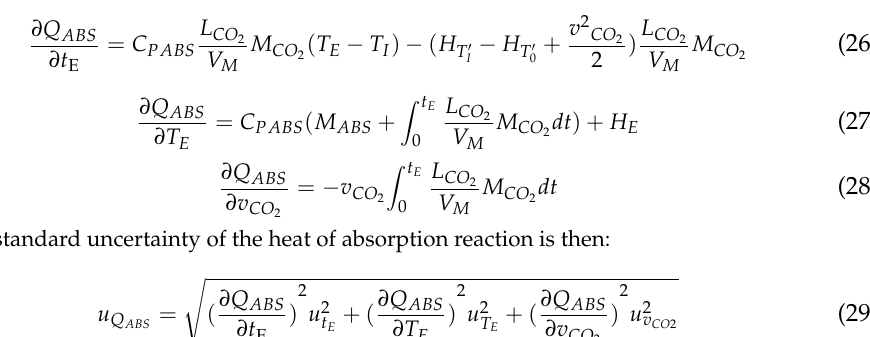
Figure 3. System thermal equivalent